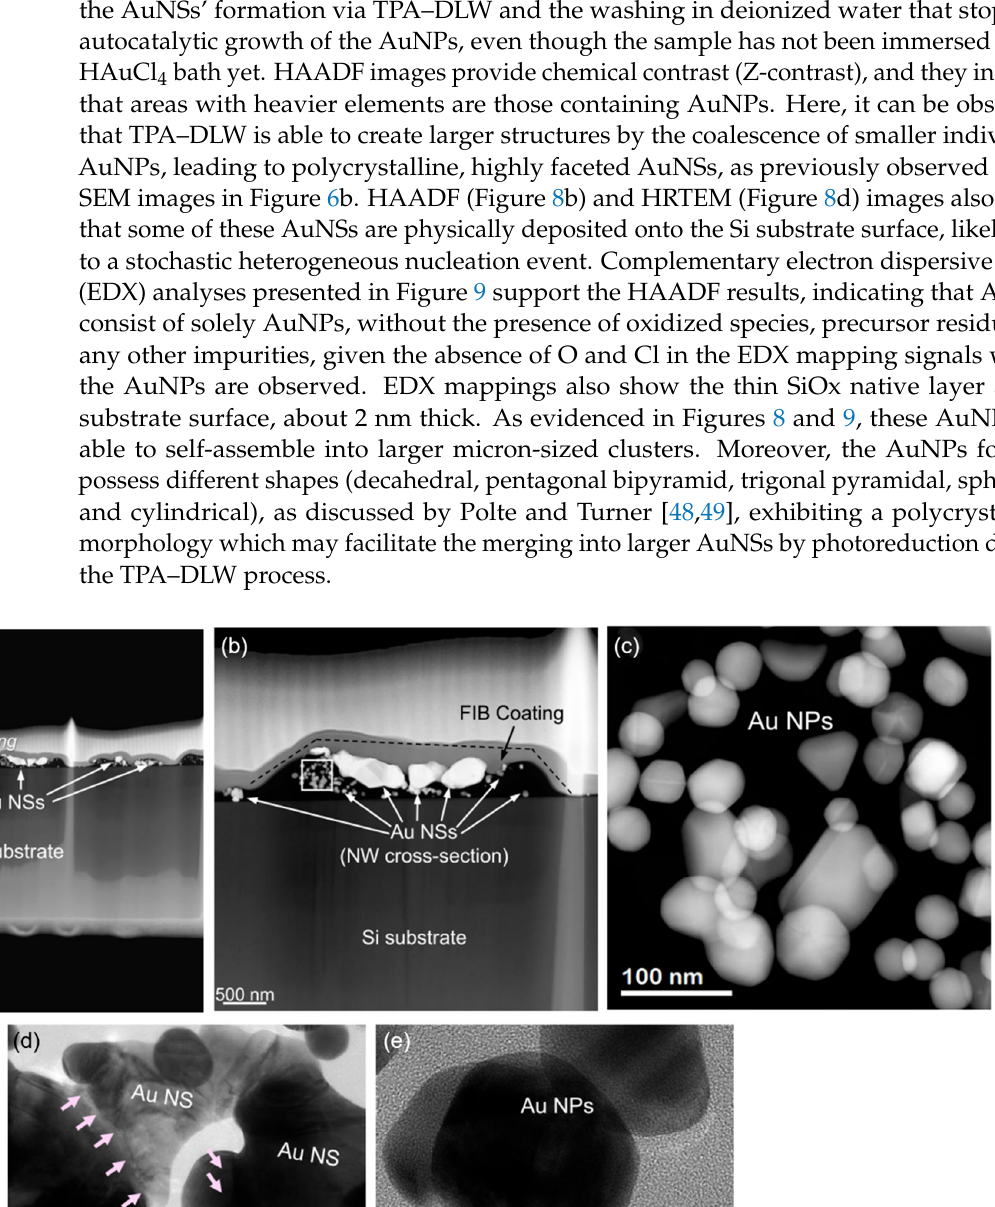
Figure 9. HAADF image and EDX maps of AuNSs made with an LP = 100 mW and ET = 150 ms. Au, Si, Pt, and O signals are displayed in yellow, magenta, orange, and cyan, respectively. AuNSs consist of individual AuNPs, which self-assem- ble into larger, micron-sized clusters. These clusters contain only Au, without any impurities (e.g., oxidized species or precursor residues). EDX also shows a thin SiOx native layer at the substrate surface (~2 nm thick).